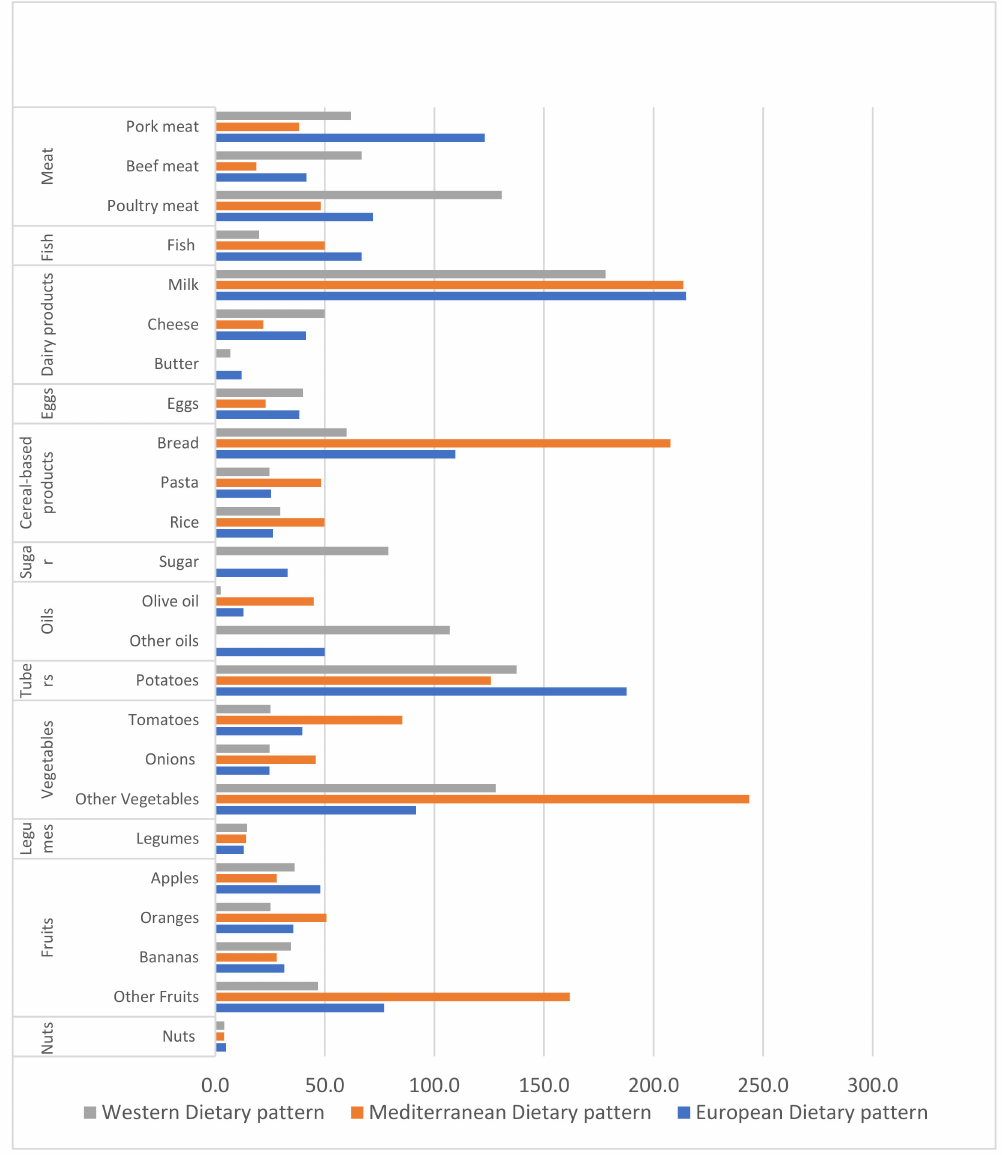
Figure 2. Description of the average food consumption scenarios used in this study per day per person per g, based on 2000 kcal person − 1 day −